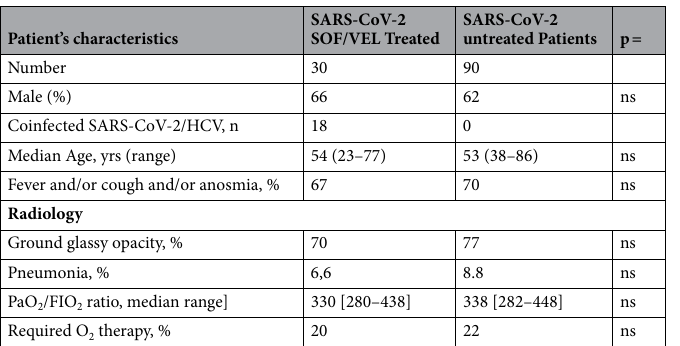
Table 1. Demographic and clinical characteristics at presentation of the enrolled patients. ns = not